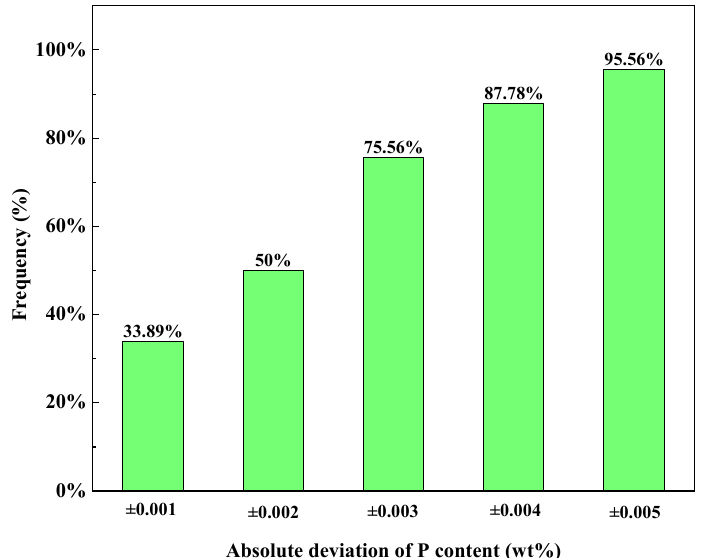
Figure 11. Frequency of absolute deviation in the prediction model optimized with time of the first addition of lime.